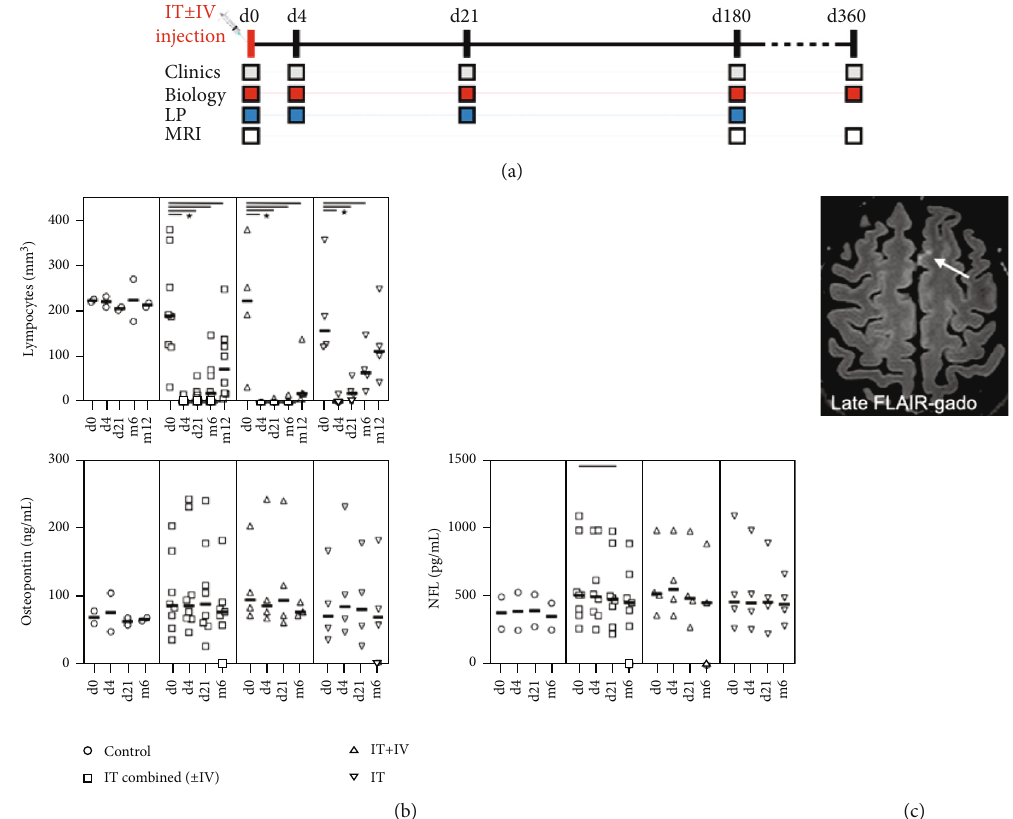
Figure 1: Study timeline and main results. (a) Schedule of investigations (from day 0 to 360). (b) Lymphocyte count decreased in treated groups. OPN and NFL levels remained mostly stable over time. ∗ p < 0 : 05 . (c) Leptomeningeal enhancing lesion (LME) on basal MRI (#6), late-acquired axial FLAIR-enhanced sequence. Absence of overt change in control MRIs (not shown). Table 1: Patient characteristics. Patients 9 and 10 were, respectively, patients 7 and 8 rerandomized to active groups after completion of study in control arm. CP: cyclophosphamide; Ctl: control group; DMF: dimethylfumarate; IFN: interferons; IT: intrathecal rituximab group; IT+IV: intrathecal and intravenous rituximab group; MTX: methotrexate; PP: primary progressive MS; SP: secondary progressive